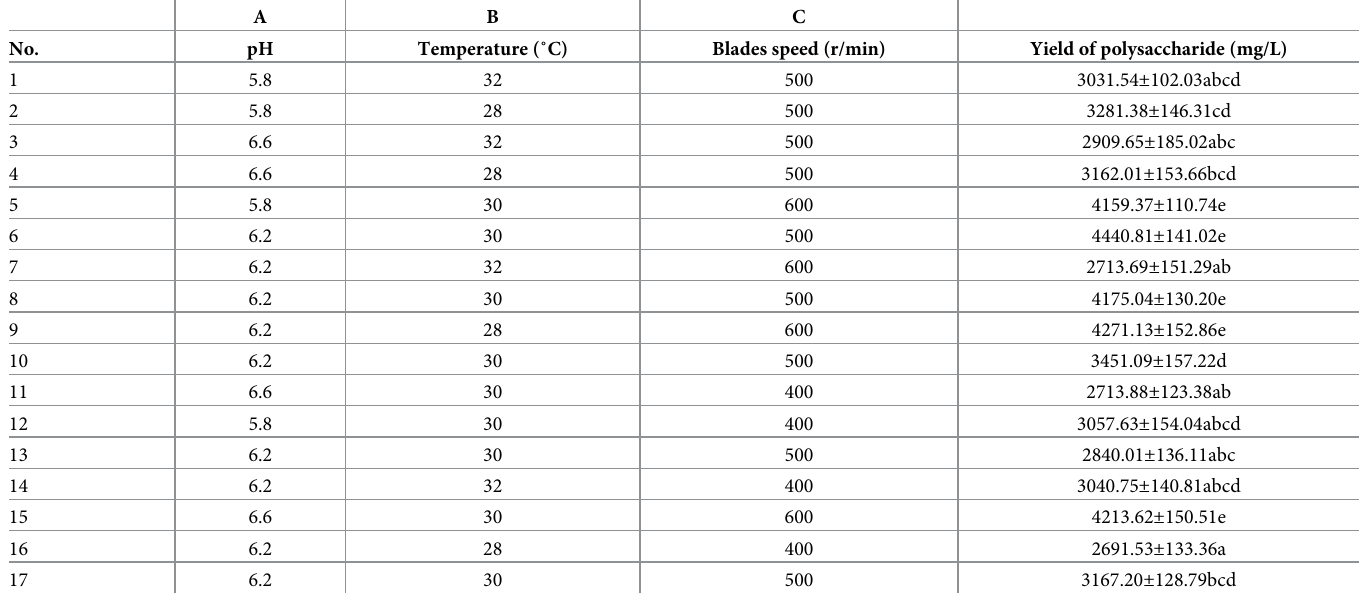
Table 6. Response surface test of fermentation conditions.